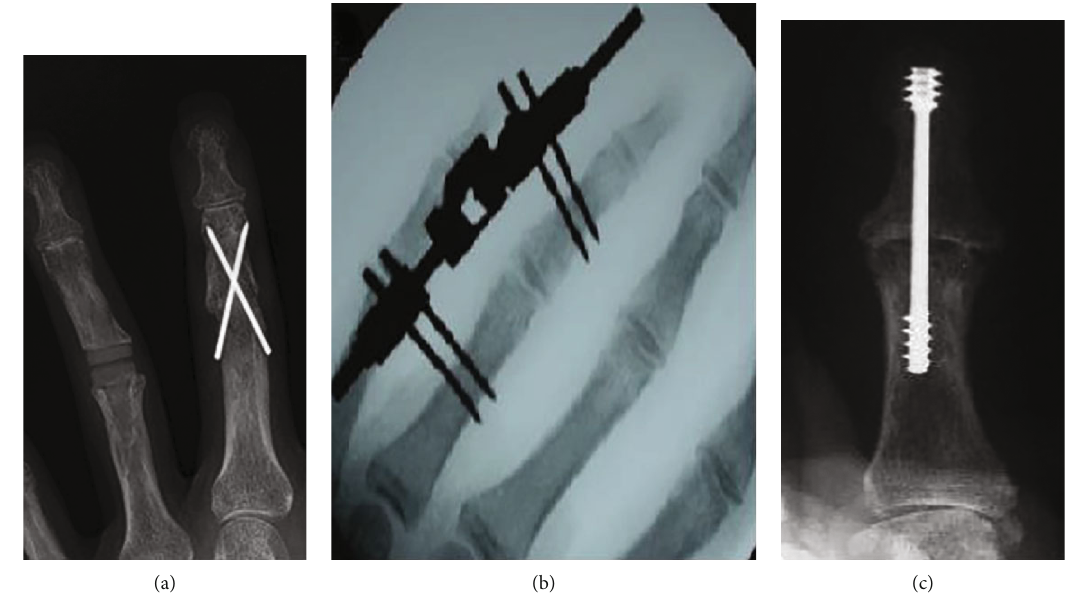
Figure 1: Arthrodesis of fi nger joint such as (a) Kirschner wires (K-wires), (b) external fi xation, and (c) screw fi